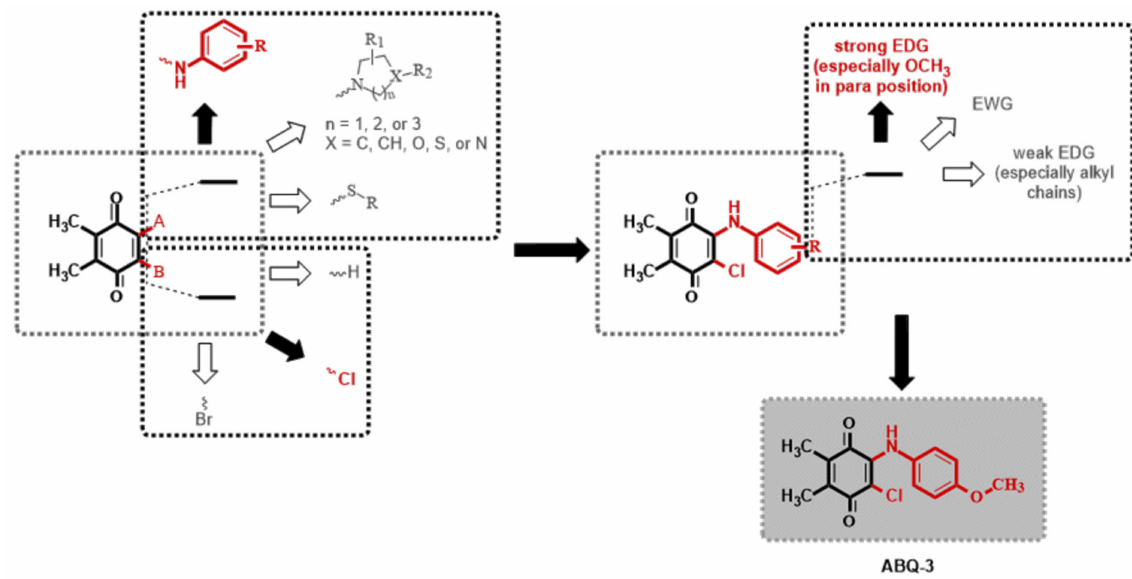
Figure 2. Possible modifications of dimethyl-1,4-benzoquinone moiety within our previous studies and the selection of a target analog (Both black filled arrow and red colored moiety are used to indicate the selected structure in this study. On the other hand, a white filled arrow and dark grey colored moiety are used to show other possible moieties not included in this